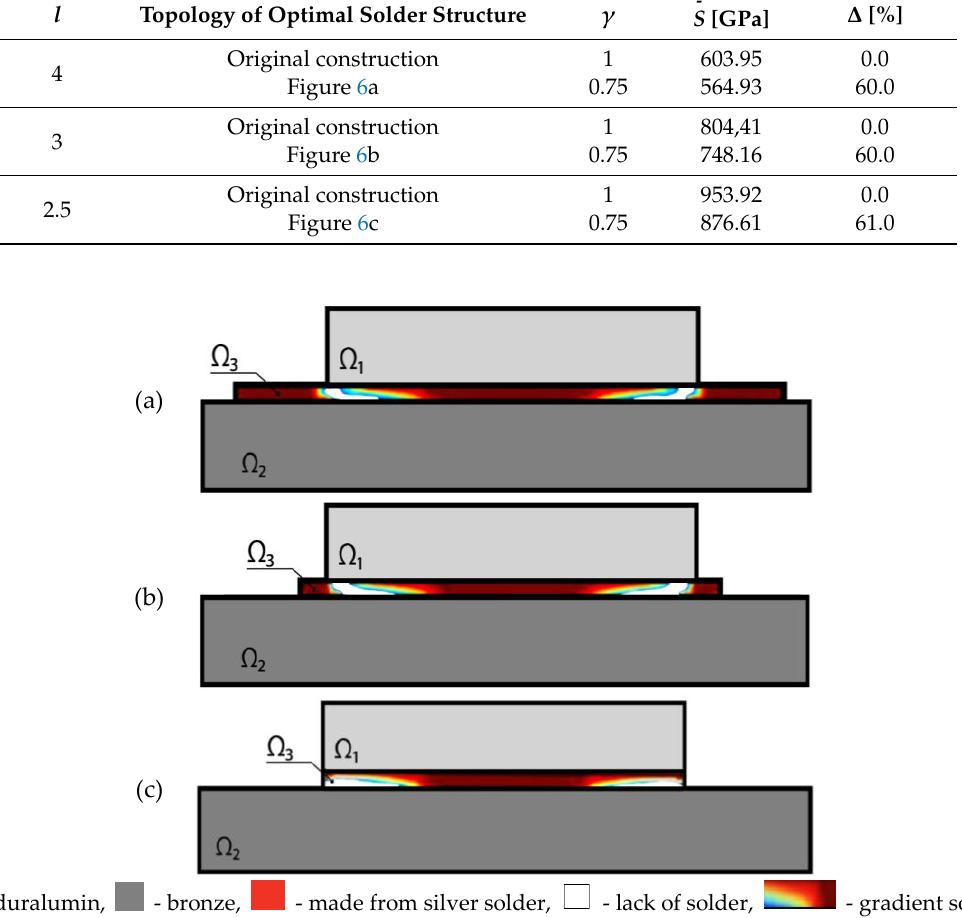
Figure 7. Curves of the distribution of shear stresses along the upper (1,2) and bottom (3,4) boundary of the solder area.